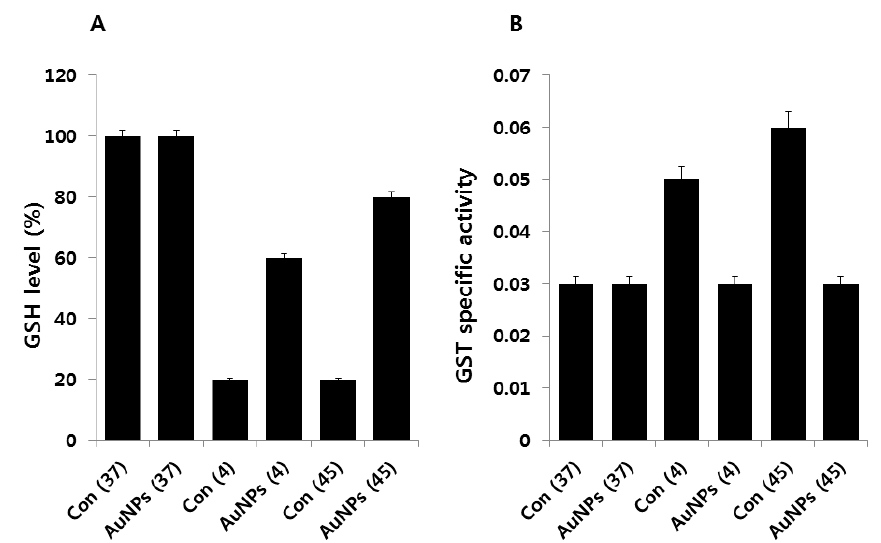
Figure 7. Effect of AuNPs on GSH and GST activity. ( A ) E. coli cells were pre-incubated with AuNPs (1 μ g/mL) for 1 h, stressed at 4 °C or 45 °C, and subsequently recovered for 12 h at 37 °C. The amount of GSH was measured enzymatically in the clear supernatant based on the reduction of 5,5 ′ -dithiobis-(2-nitrobenzoic acid) by the GSH reductase system; ( B ) GST activity was determined as